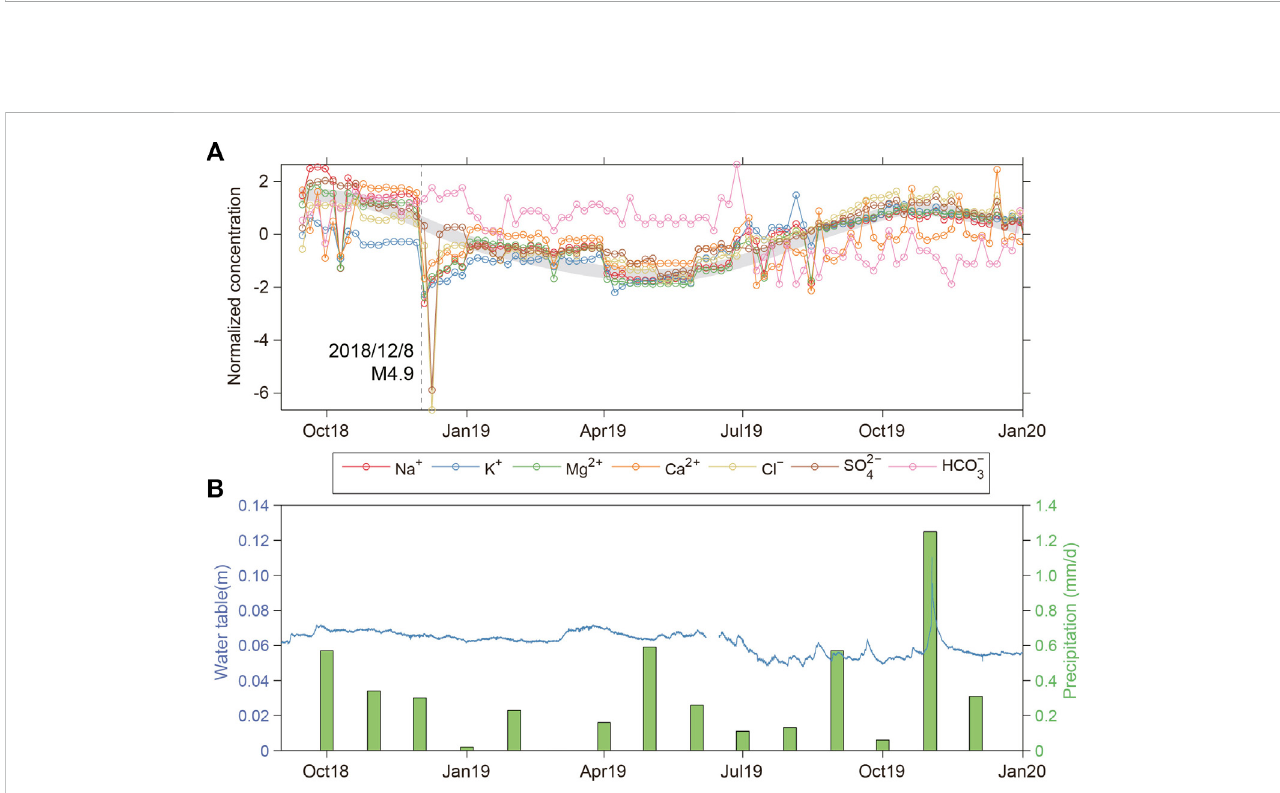
FIGURE 4 Variation of major elements during the study period (A) and the comparison diagram of dynamic water level and precipitation in the X10 spring (B) . The gray dashed line in (A) represents the 8 December 2018, Hutubi M 4.9 earthquake in Xinjiang, China.